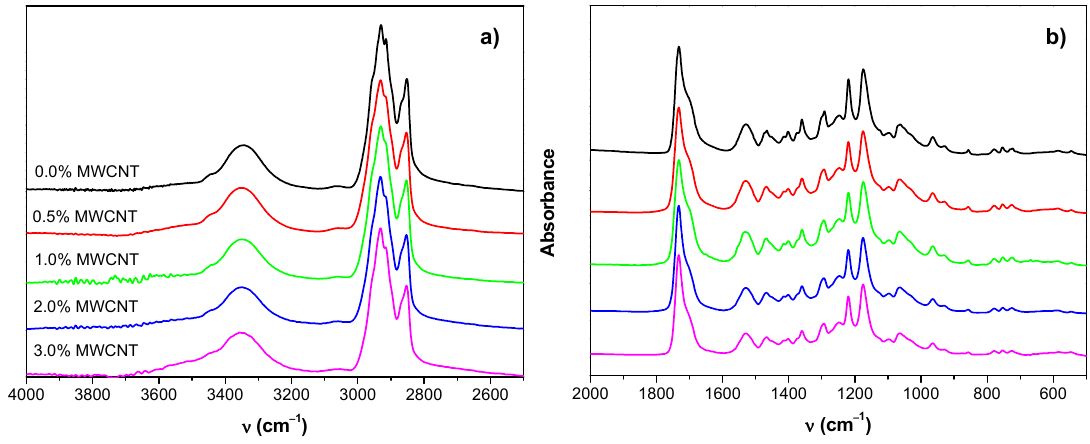
Figure 5. FTIR spectra of all the prepared samples: ( a ) high-energy region; ( b ) low-energy region.